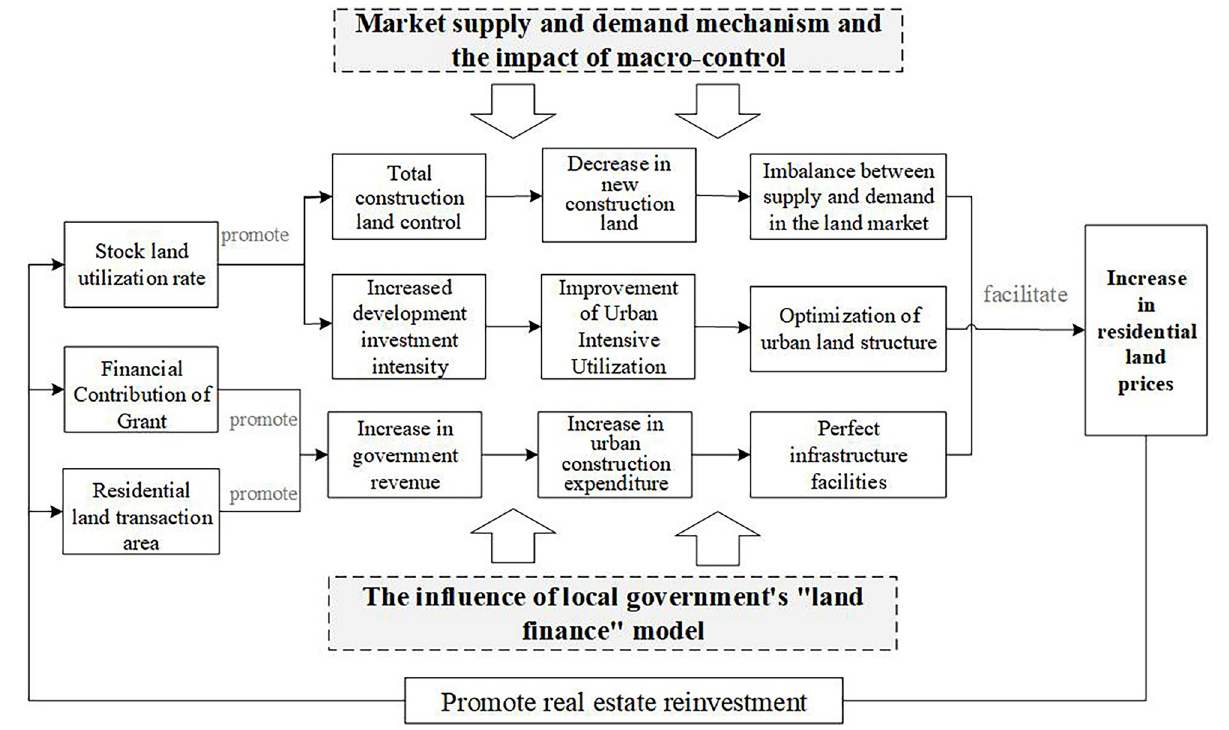
Fig 5. The mechanism of the factors promoting the rise of residential land